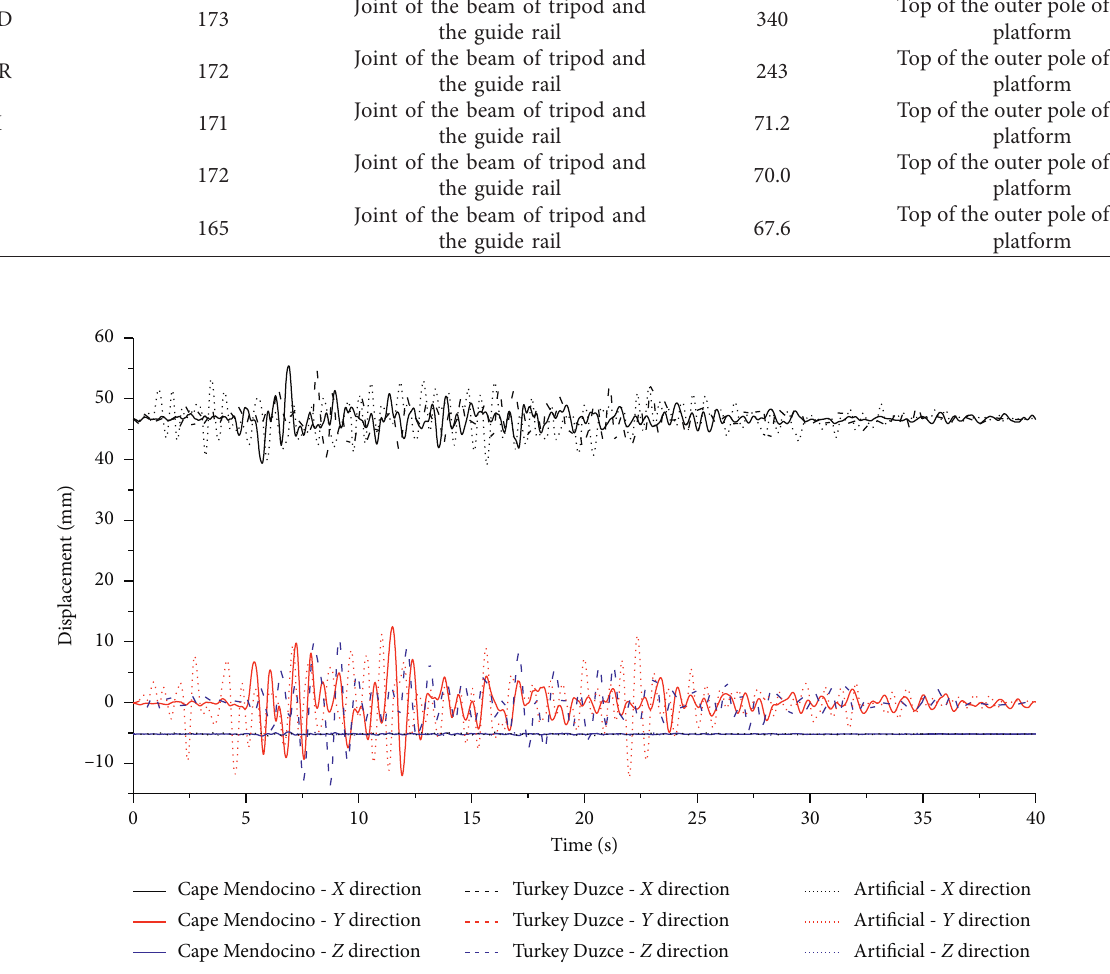
Figure 14: Displacement–time curves of climbing formwork without core tube under the climbing